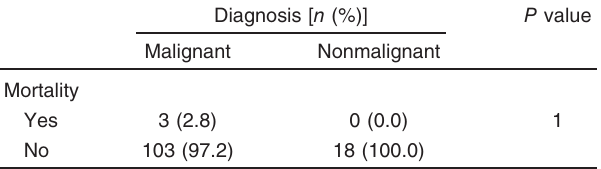
Table 6 Relation between diagnosis and mortality